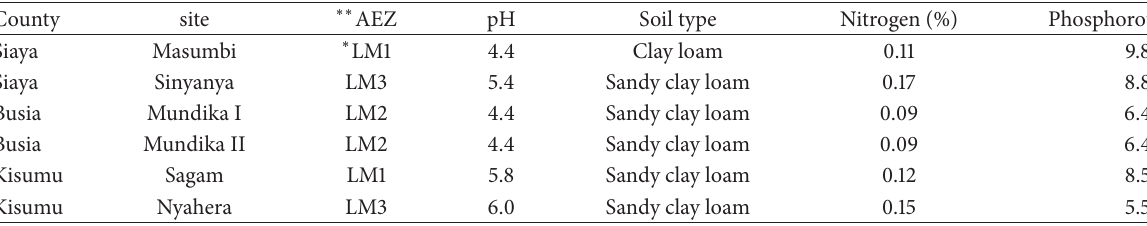
∗ Lower midland zone. ∗∗ Agroecological zone.